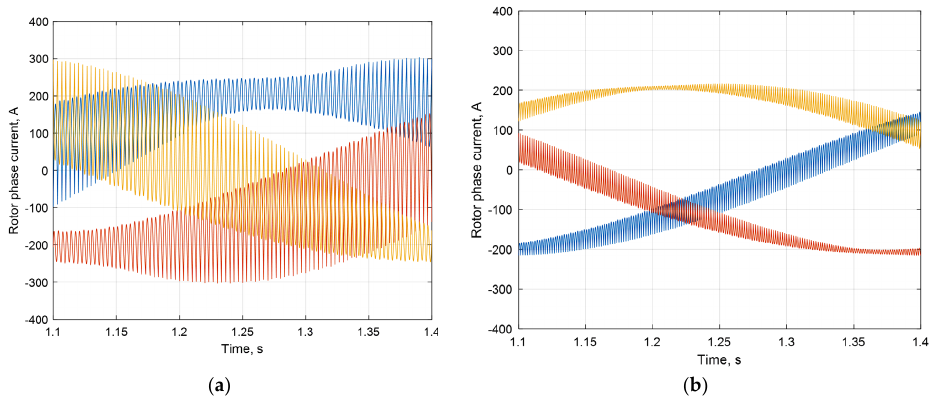
Figure 18. Rotor currents of 3PIM ( a ), rotor currents of 6PIM ( b ) in steady-state mode: ph. A—blue, ph. B—red, ph. C—yellow.